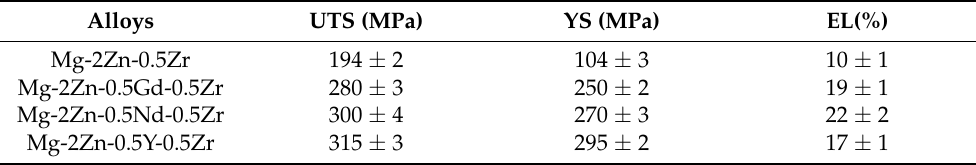
Figure 7. Stress-strain curves of the alloys after the four-pass extrusion. Table 5. Mechanical properties of the alloys after the four-pass extrusion.